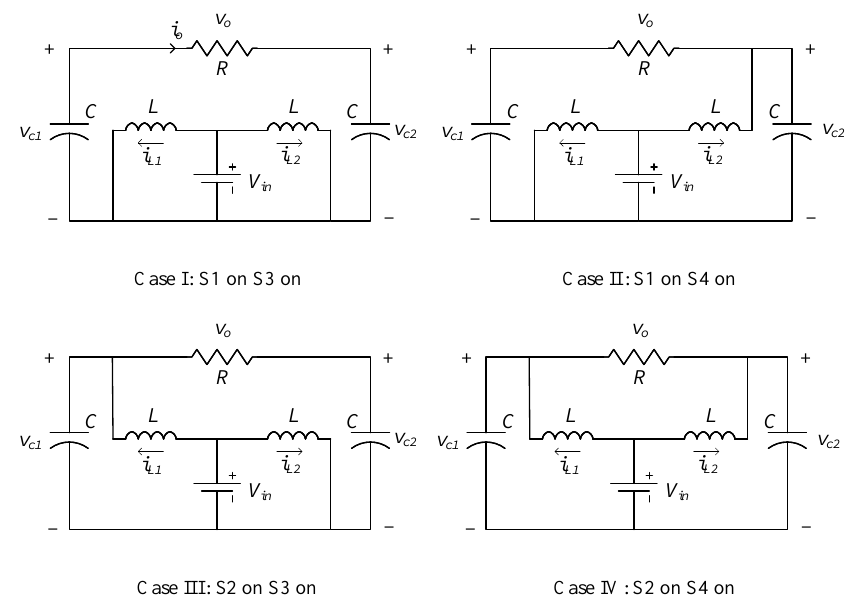
Figure 2. Four different switching cases for the boost